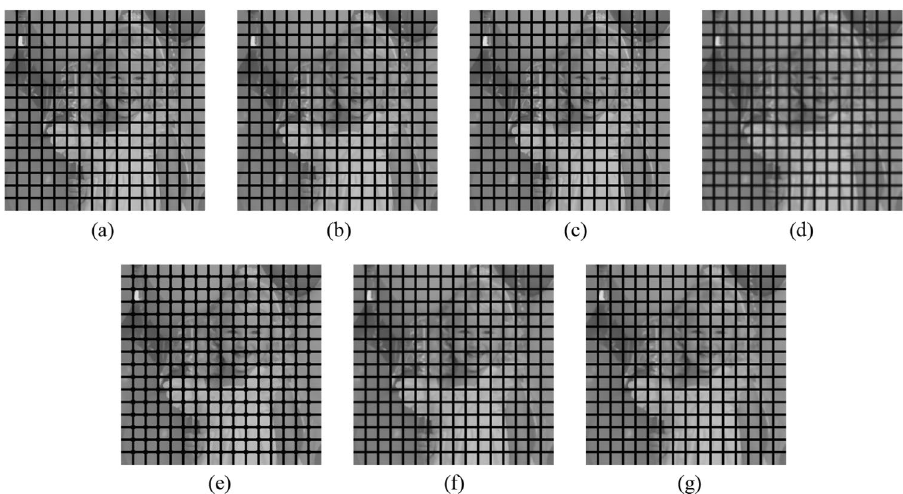
Figure 29. Comparison of edge preservation performance of each filter (“Balloon”). ( a ) Grid-added image; ( b ) filtered image using abwFMGFI; ( c ) filtered image using NLMF (templateWindowSize: 21, searchWindowSize: